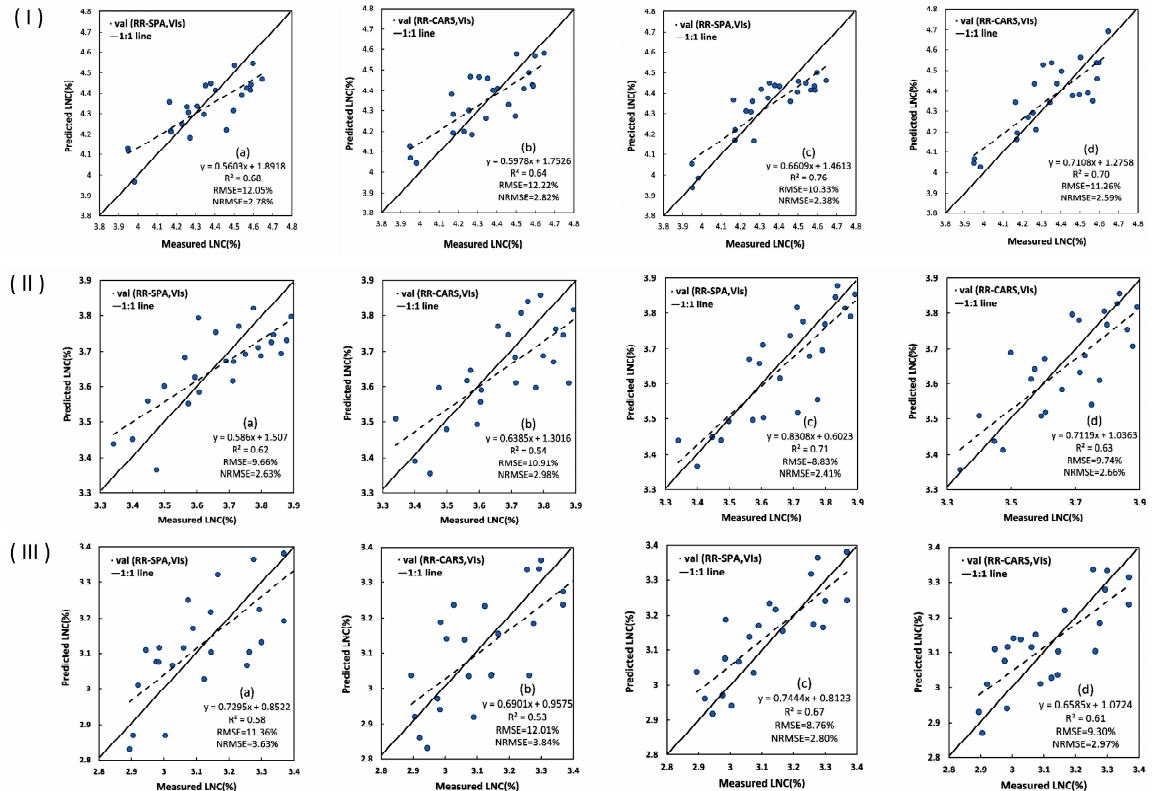
Figure 13. Predictive performance for each stage. ( I – III ) represent the Rice Jointing, Booting and Filling stages, respectively. ( a ) Using RIDGE-SPA for denoised original multispectral images; ( b ) Using RIDGE-CARS Regression for denoised original multispectral images; ( c ) Using RIDGE-SPA for denoised fusion images; ( d ) Using RIDGE-CARS for denoised fusion images.